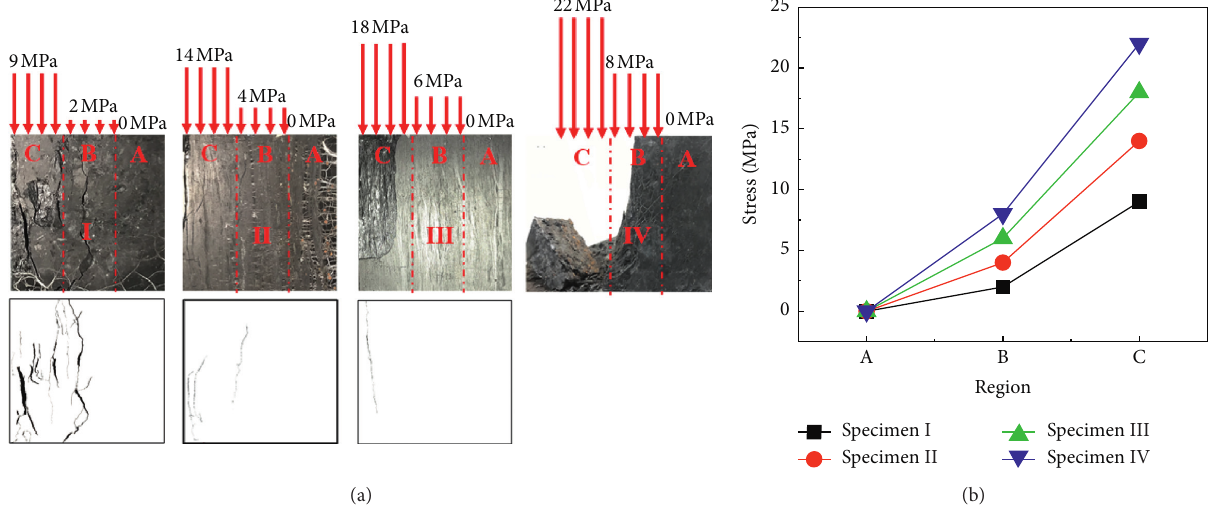
Figure 7: Influence of stress gradient on failure characteristics of coal rock. (a) Failure characteristics of the specimen. (b) Stress distribution in different